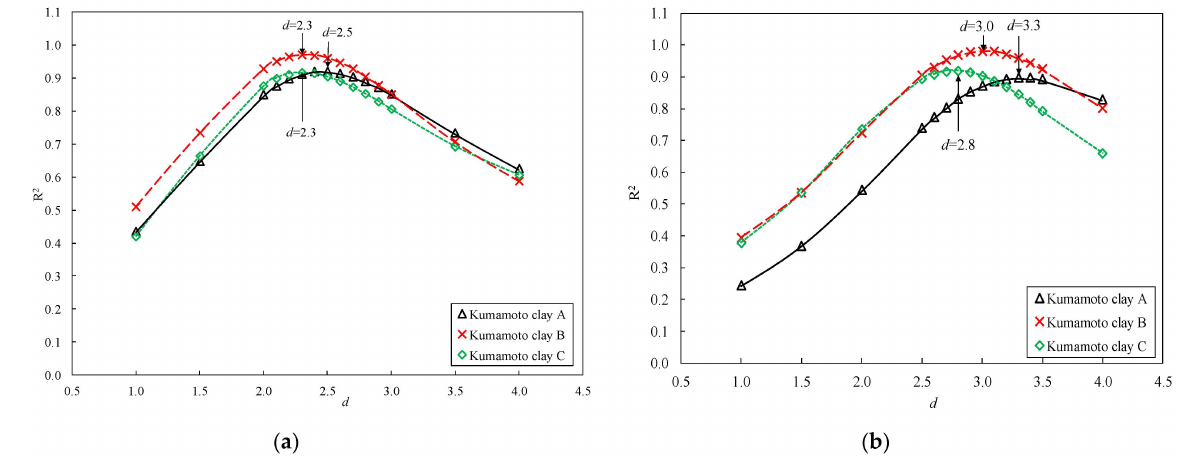
Figure 10. Change in correlation coefficient R 2 of Equation (4) based on different d of clay stabilized by OPC or DF. ( a ) Stabilized clay by OPC, ( b ) Stabilized clay by DF.